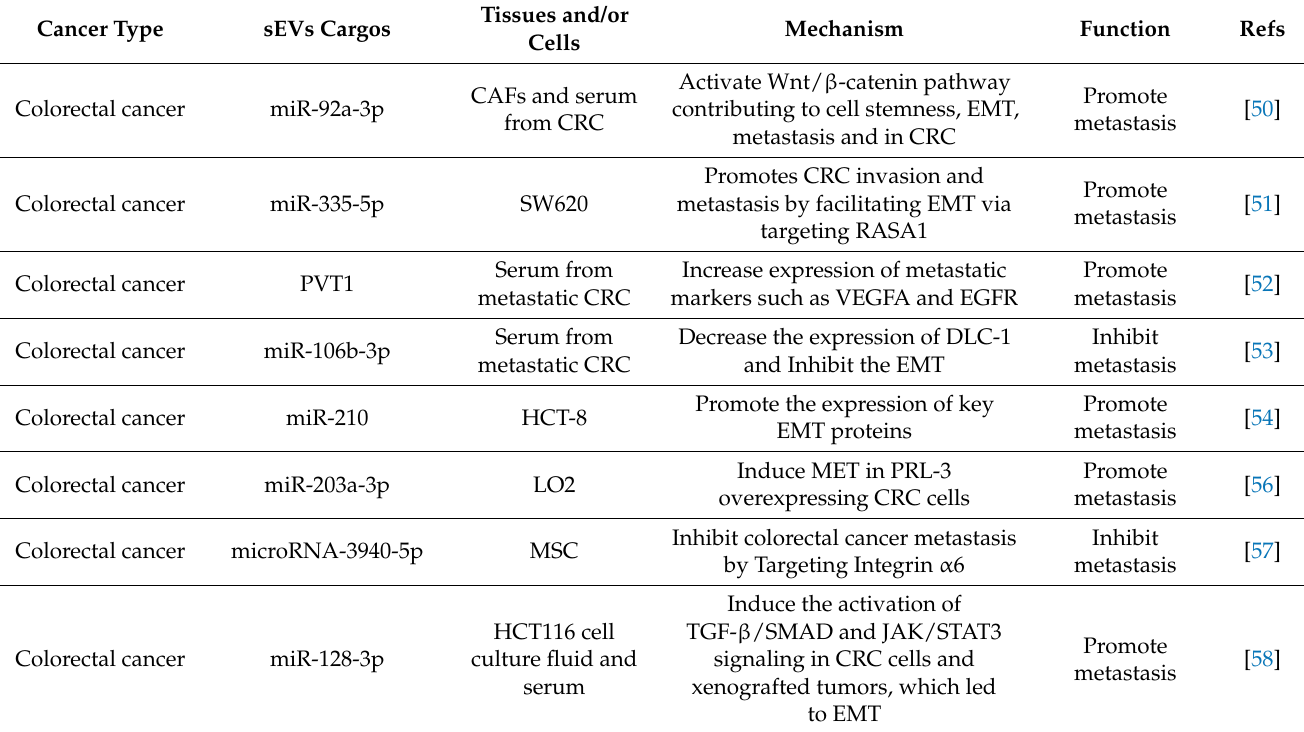
Table 2. sEVs related with colorectal cancer metastasis by